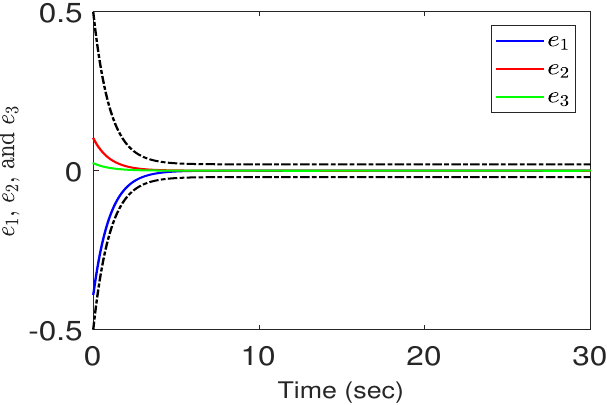
Figure 7. Tracking errors vs. time under a PPC in Case 2